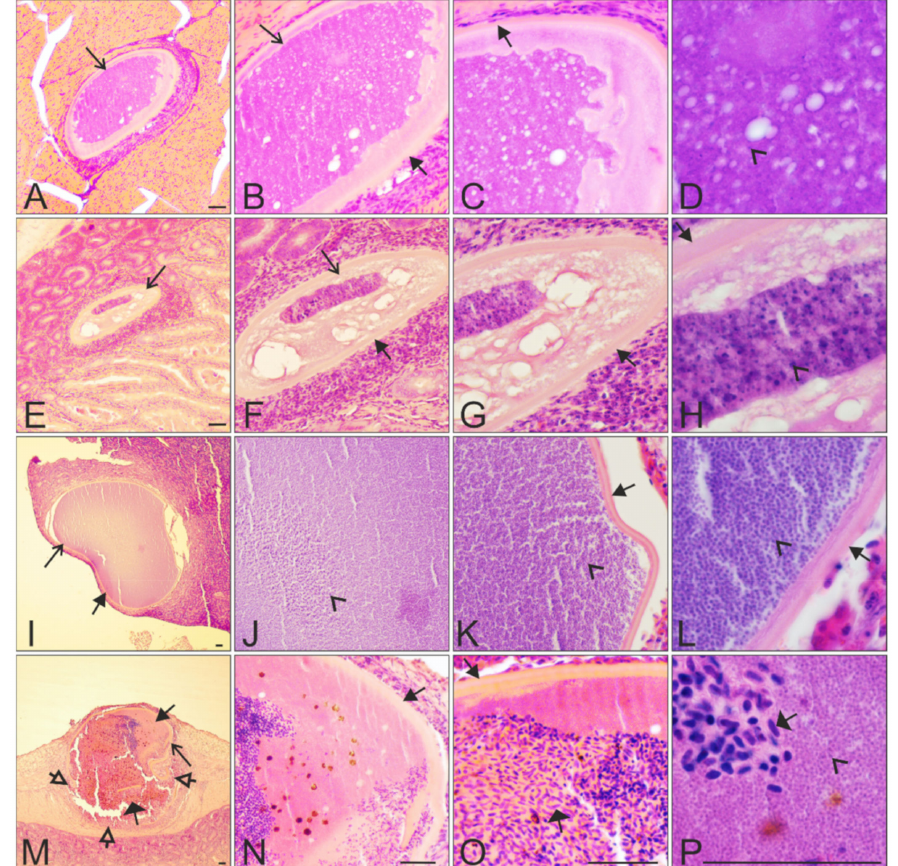
Figure 4. Megalomeronts of Haemoproteus pastoris (lineage hLAMPUR01) in the gizzard ( A – D ), the intestine ( E – H , M – P ), and the pancreas ( I – L ) of naturally infected Common starlings Sturnus vulgaris . Note the prominent capsular-like wall covering each megalomeront ( B , C , F – H , K , L , N , O ), the oval-shape of two megalomeronts ( A , E ), and the big size-difference between developing and mature megalomeronts ( A , E vs. I , M ). Megalomeronts were seen at different stages of development: E–H growing immature, A – D growing maturing, I – L completely mature, and M – P ruptured mature at the stage of degeneration. The megalomeront shown in E – H seemed to present cytomeres at two degrees of maturation, with the more mature merozoites in dark-purple color ( H ) while the rest of the megalomeront remained light pink and showed a less-developed structure; this could indicate an asynchronous development of cytomeres within the same megalomeront. Megalomeronts with a ruptured wall ( M ) showed marked infiltration of blood cells ( M – P ), with still some merozoites present ( P ). Each megalomeront is shown at five different magnifications: I , M × 40; A , E , × 100; B , F , J , N × 200; C , G , K , O × 400, and D , H , L , P × 1000. Simple arrows ( )—megalomeront. Filled-black triangle arrows ( )—capsular-like wall. Contoured-black triangle arrows ( )—rupture of the capsular-like wall. Flat triangle arrows ( )—red blood cells invading the megalomeront. Simple arrowheads ( )—merozoite. All scale bars = 40 µ